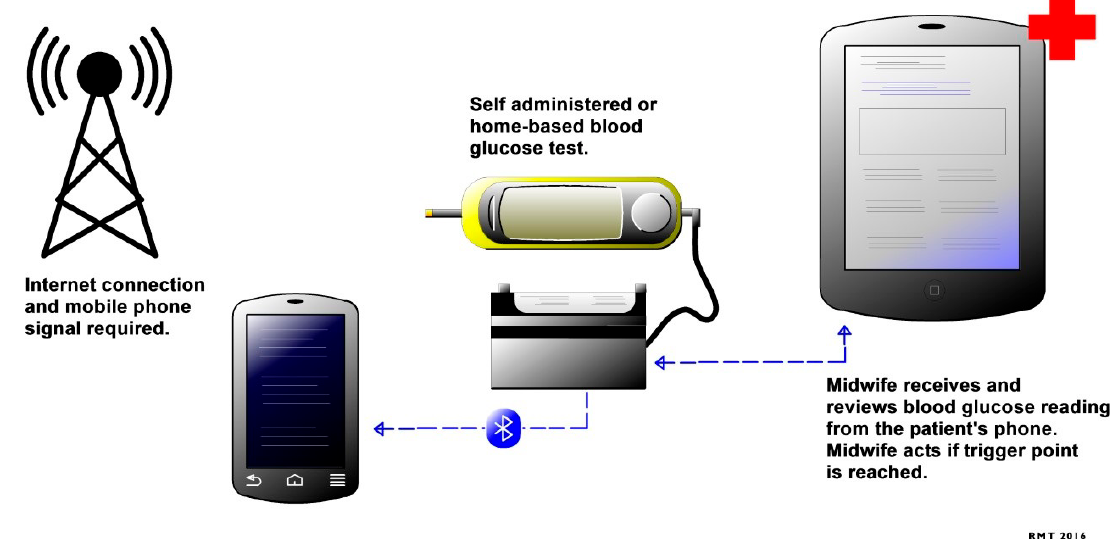
Figure 1. Mobile health system for management of gestational diabetes mellitus adapted from Mackillop et al., 2014 [45].